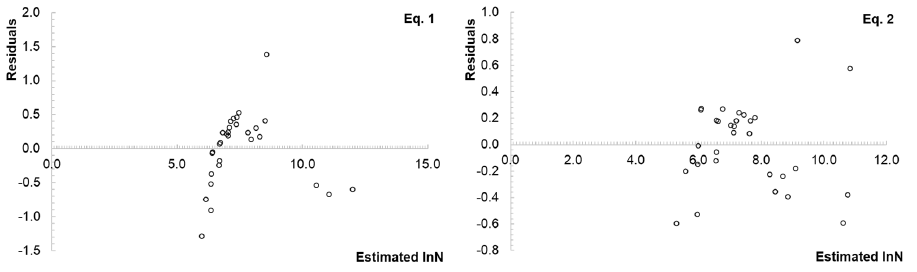
Figure 4. Plots of the residuals for the fitted linear model ( Equation 1) and the quadratic model ( Equation 2).